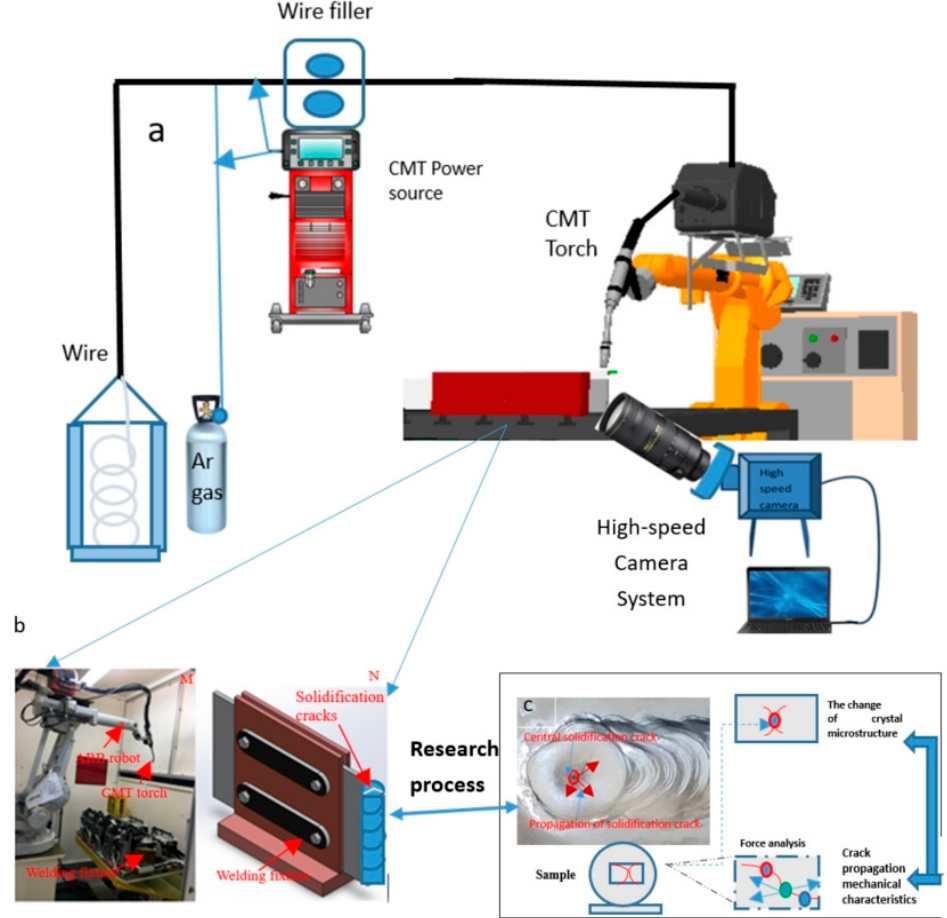
Figure 1. Cold metal transfer (CMT) processing experimental equipment and process. ( a ) CMT welding solidification crack test platform; ( b ) CMT welding processing; ( c ) research process.